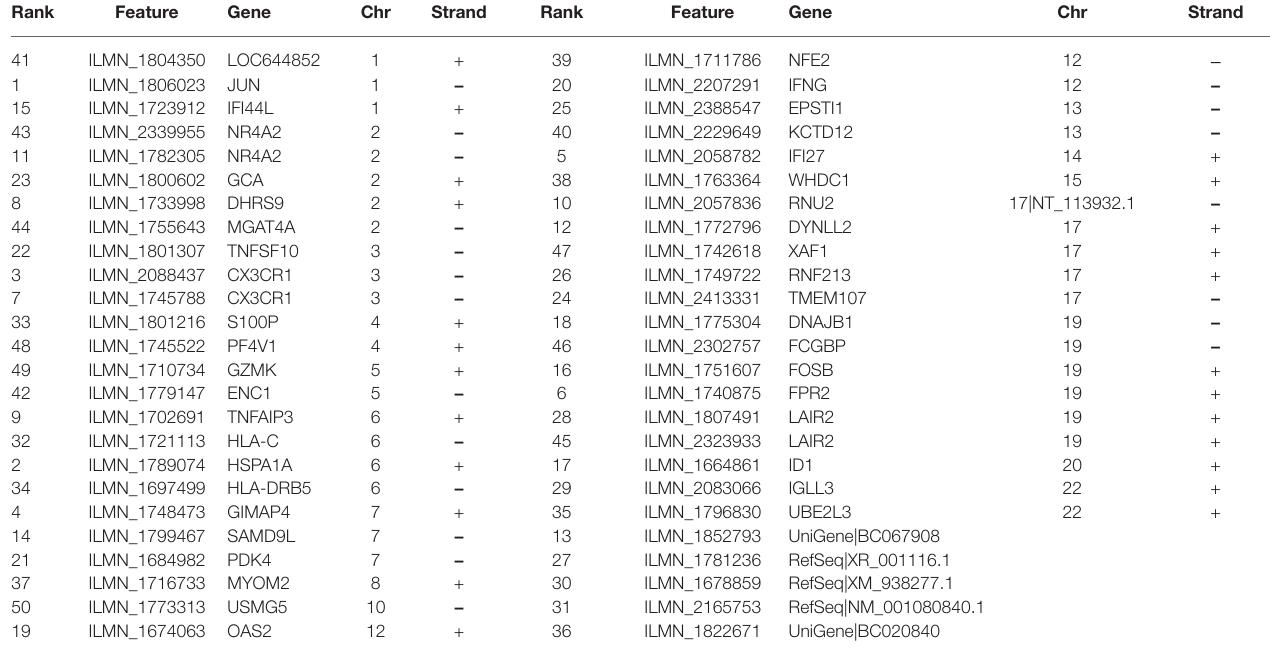
Table 3 listed the 50 EnRank-detected biomarkers and their corresponding gene information. Many transcriptomic biomarkers are from chromosomes 19 and 2. And two biomarkers TABLE 3 | Detailed information of the 50 EnRank-detected